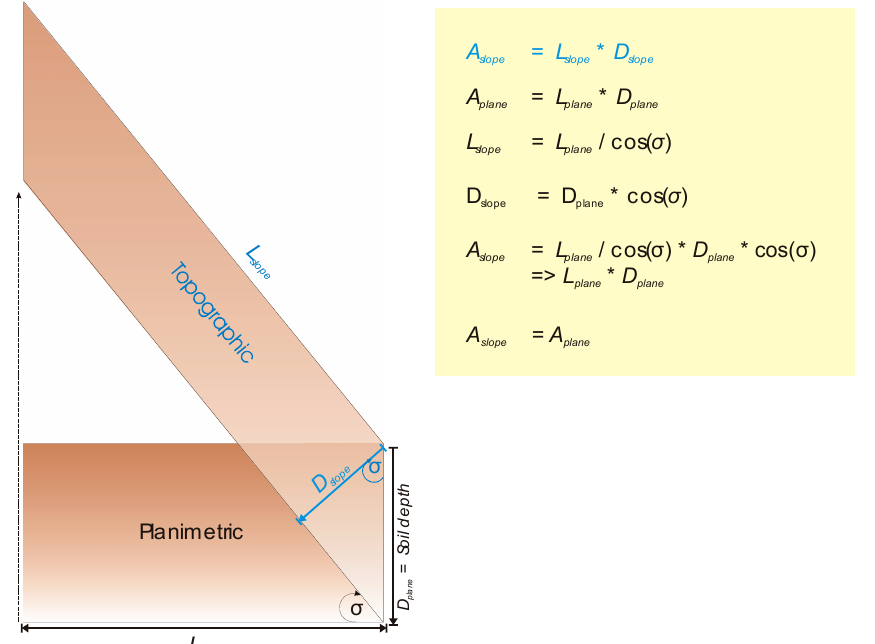
Figure 1. Invariability of soil volume with slope, exemplified by the perpendicular height of a parallelogram area.